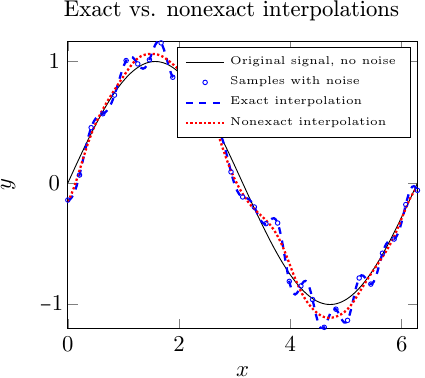
Figure 4. Exact and nonexact interpolations of a sine signal with